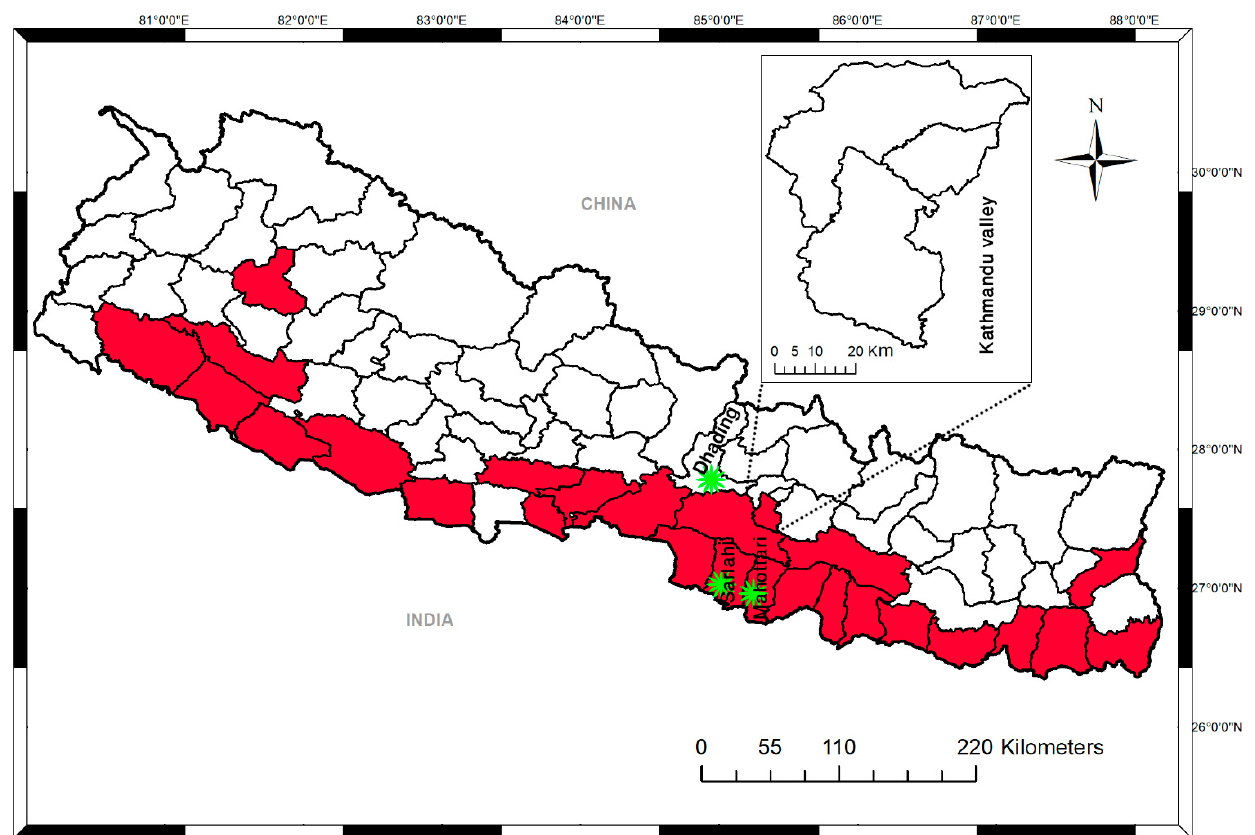
Figure 1. District-level map of Nepal showing the study sampling sites and areas affected by flooding and landslides in 2017. Areas in red indicate the districts affected. Asterisks indicate the sampling sites.